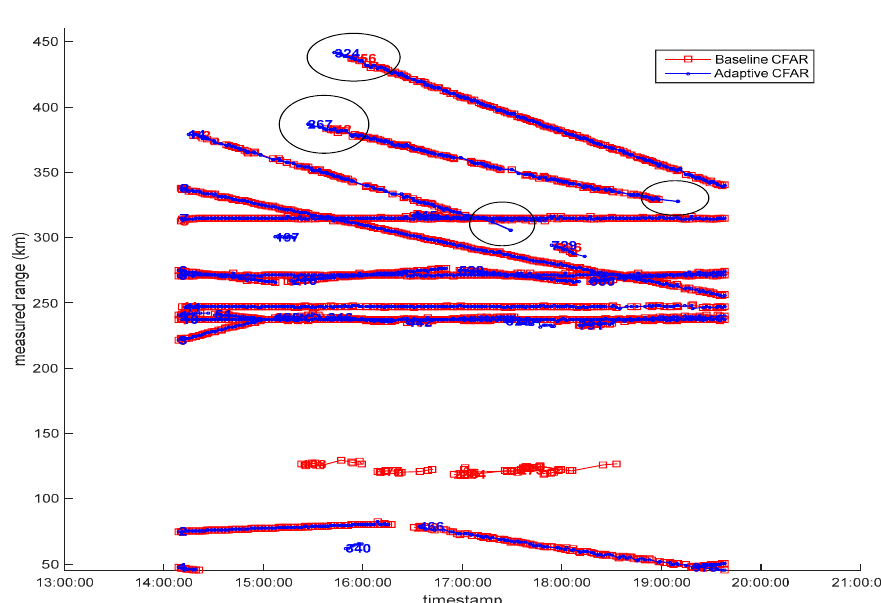
Figure 11. Overlay of range vs. time track picture via baseline and adaptive CFAR detectors. It can be observed that the adaptive CFAR detector extended the track life and initiated tracks earlier (circles above a range of 250 km), and that a number of false tracks arising from ionospheric clutter or other sources (at 120 to 140 km) were completely eliminated from the track picture.